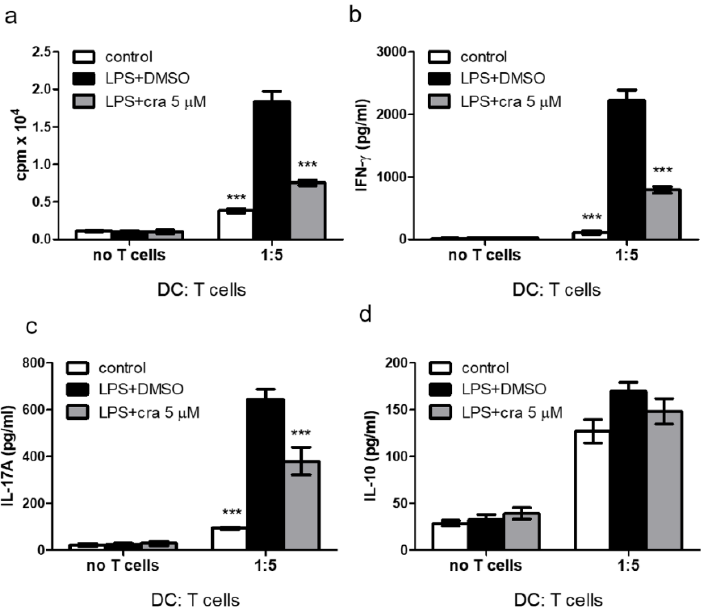
Figure 4. Effects of crassolide on the ability of lipopolysaccharides (LPS)-stimulated BMDCs from OT-II mice, which produce CD4+ T cells which recognizes OVA 323–339 , to induce antigen-specific CD4+ T cell proliferation and cytokines production. ( a ) Cell proliferation of OT-II CD4+ T cells measured by 3 H-TdR incorporation assay after co-culturing with OVA 323–339 (OVAP 2 ) peptide and LPS-stimulated BMDCs in a 5:1 ratio with or without crassolide treatment for 96 h. ( b – d ) The amount of cytokines in the culture supernatants measured by ELISA. Data are presented as mean ± SEM of triplicate samples from one of three independent experiments. *** p < 0.001, versus LPS + 0.1% DMSO-treated group, tested by one-way ANOVA followed by Tukey’s multiple comparison test.